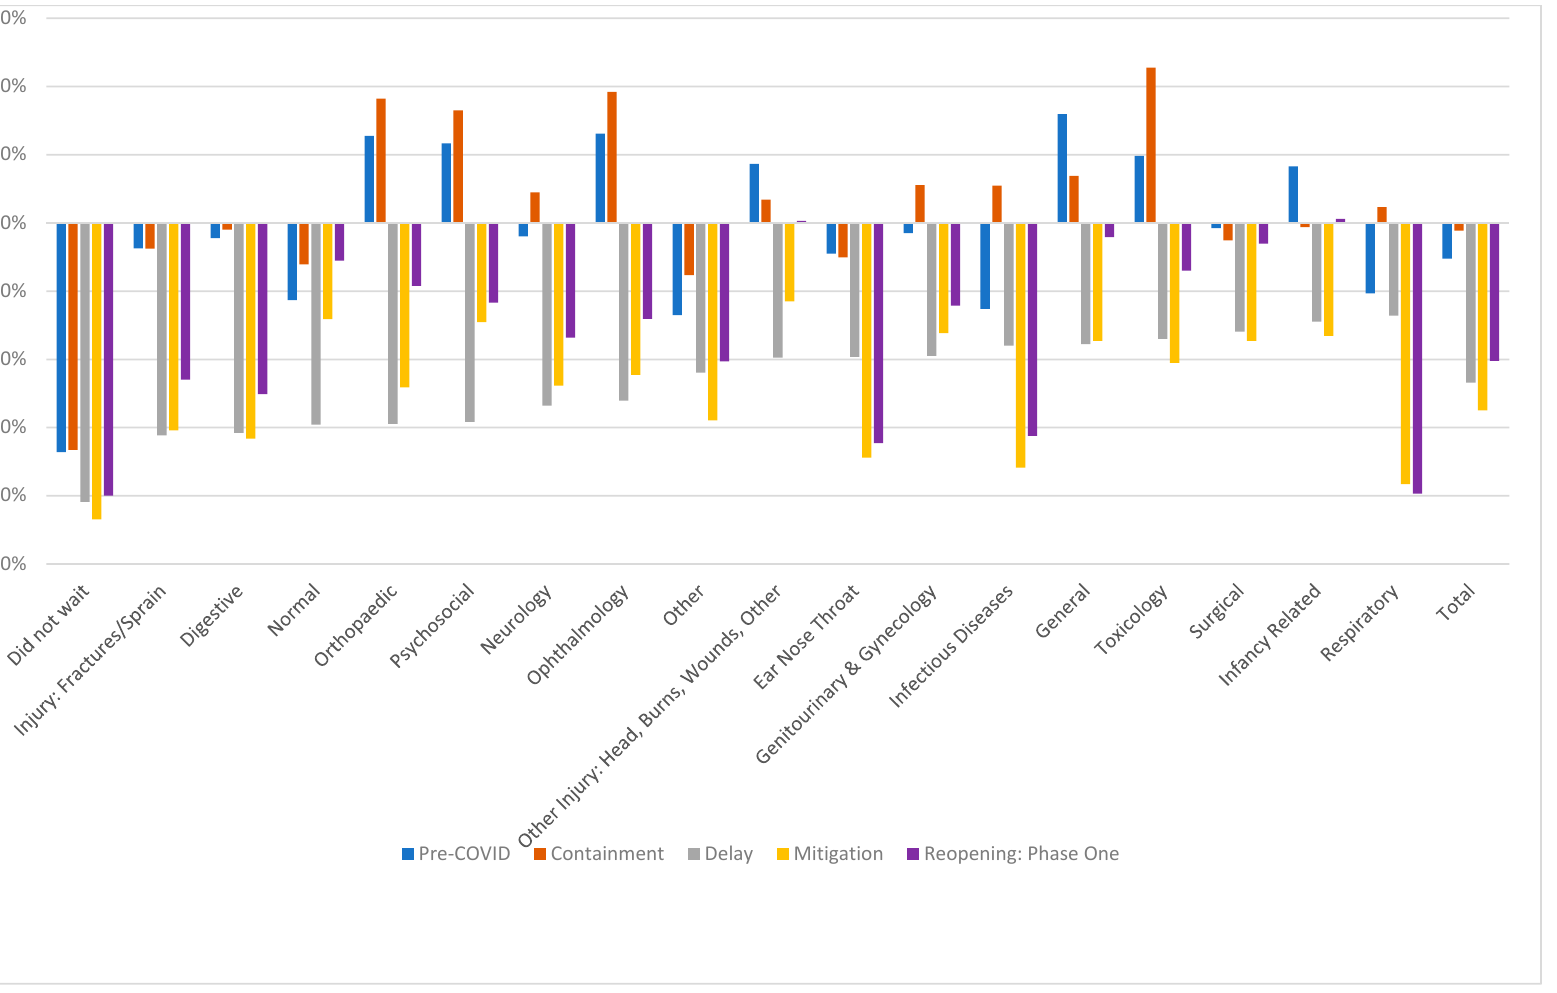
Figure 2. Change by Diagnosis from prior year by Public Health Stage. Prior year 2018/2019 is average daily attendance for comparable period in 2018 and 2019.